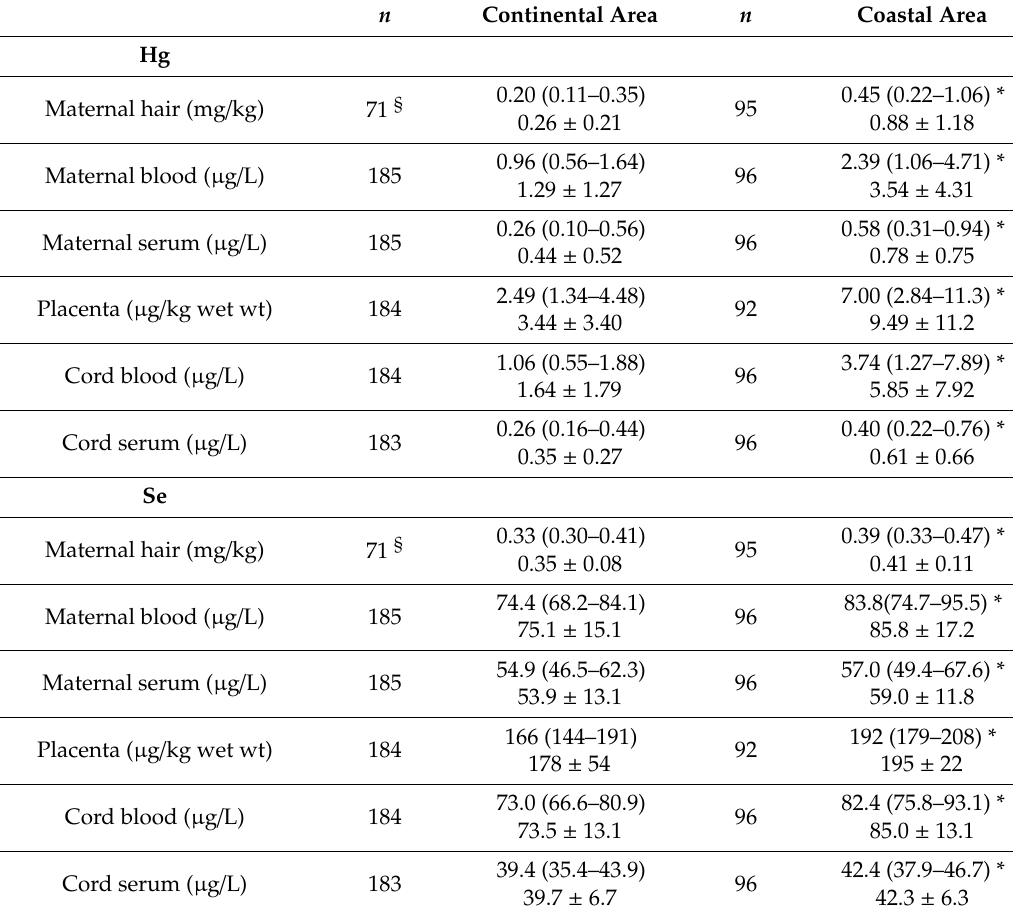
Table 2. Concentrations of total mercury (Hg) and selenium (Se) in subjects from two geographic areas of residence in